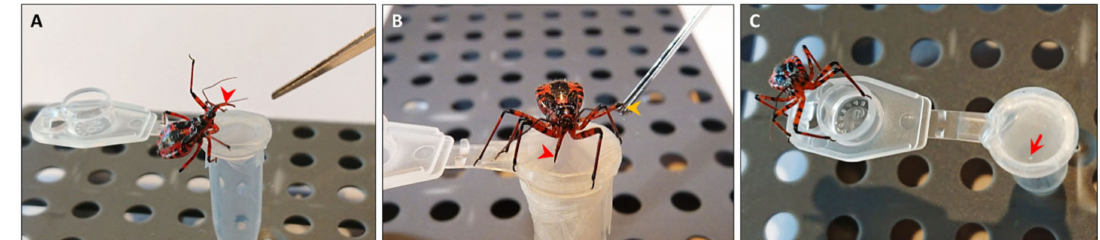
Figure 2. Rhynocoris iracundus venom collection. ( A ) To stimulate defensive venom production, R. iracundus was tapped using forceps causing it to display a defense posture and to raise its proboscis. ( B ) Then, the assassin bug was gently pinched on a rear leg (yellow arrowhead) with forceps causing it to use its proboscis (red arrowhead) to stab through the Parafilm stretched over a microcentrifuge tube. ( C ) Small venom drop released by the assassin bug on the Parafilm (red